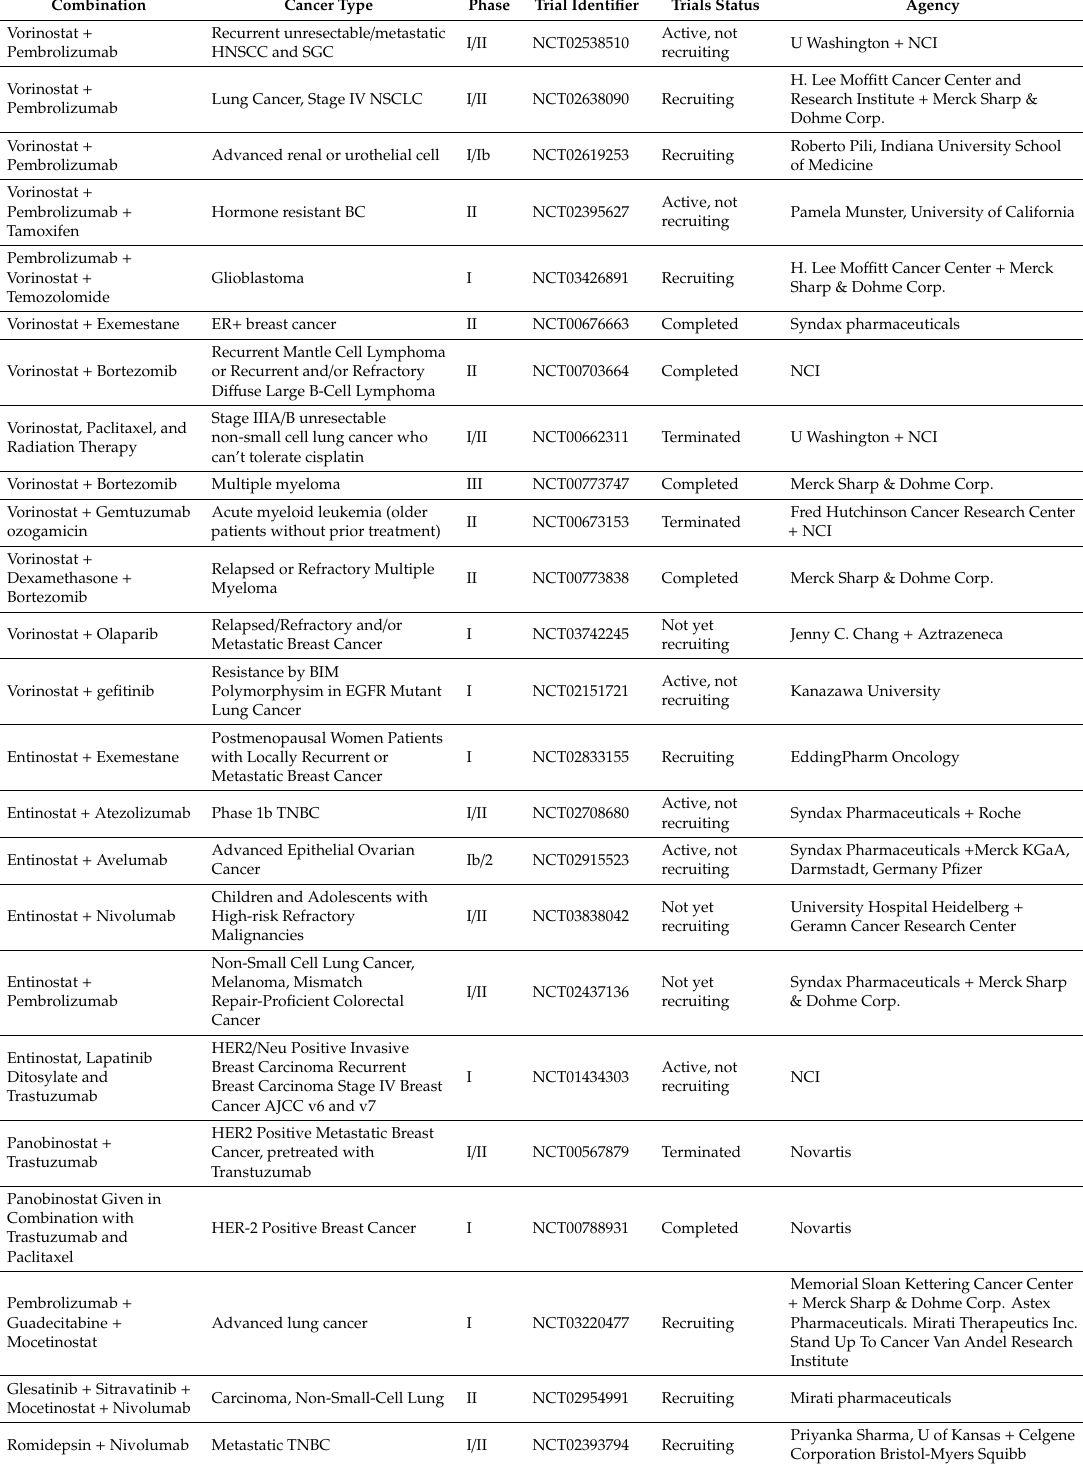
Table 3. Compilation of recent clinical trials with combination of pan-HDACi and immunotherapeutic / chemo-immune